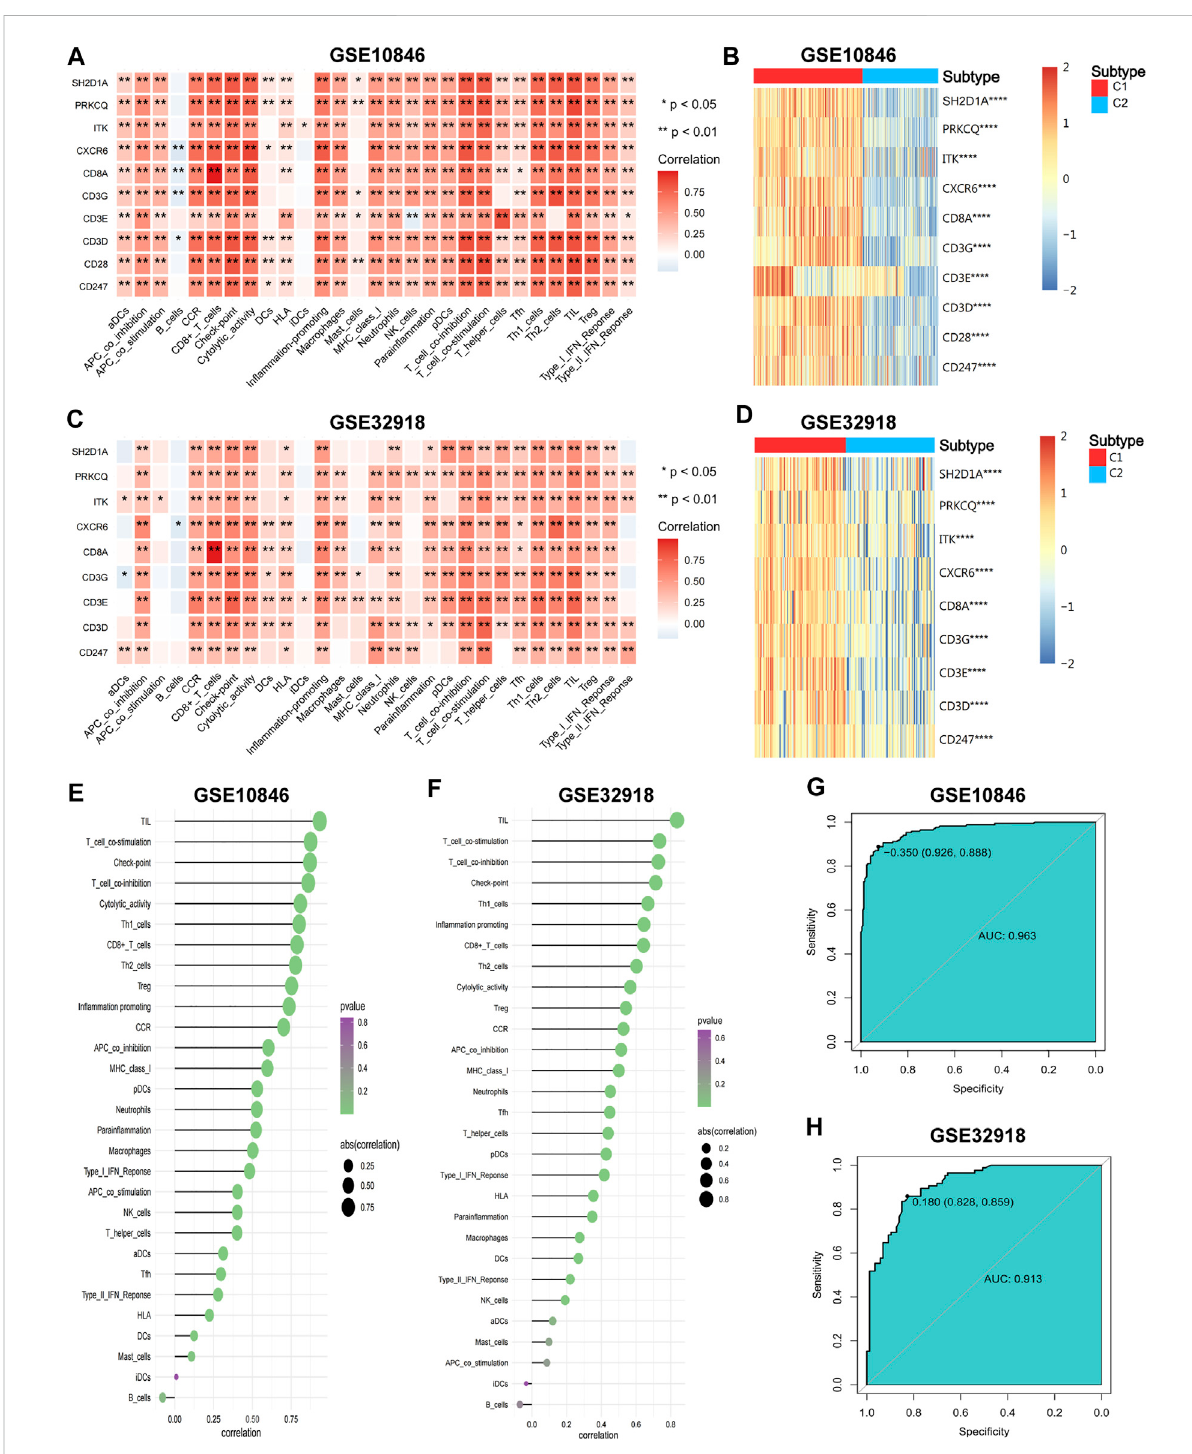
FIGURE 9 The correlations of hub genes and DLBCL immune microenvironment. (A – C) The correlations of hub genes and immune cell contents. (B – D) The expression differences of hub genes between the two subtypes. (E,F) The correlations of IRGSs and immune cell contents. (G,H) Receiver operator characteristic(ROC)curvesforIRGStopredictimmune subtypes.Wilcoxontestforcomparisonofgeneexpressionlevels between thetwo subtypes. Spearman test for correlational analyses. * p < 0.05, ** p < 0.01, *** p < 0.001, **** p <